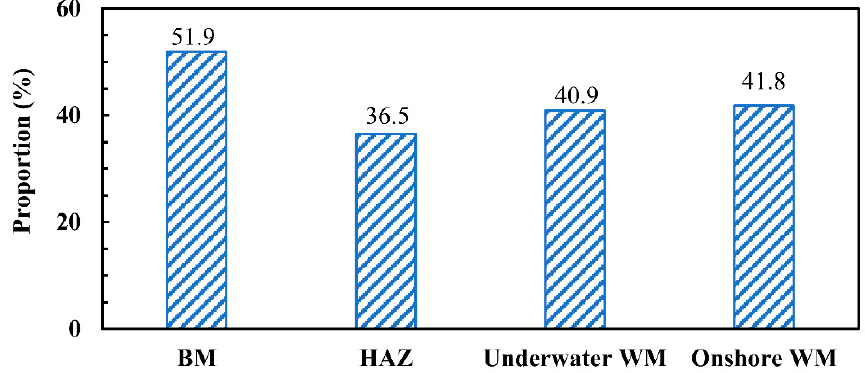
Figure 6. The phase proportions of the austenite in the ULK-TIG welded joint and onshore